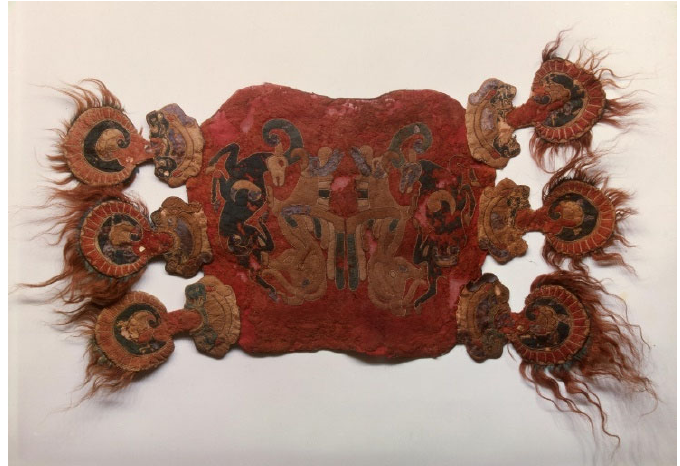
Figure 12. Saddle cover showing a griffin attacking a mountain sheep (SHM inv. no. 1295-150); felt and horsehair; Kurgan 1, Pazyryk, Altai mountains, Russia; late 4th to early 3rd century BC. [Image is used from www.hermitagemuseum.org (accessed 9 November 2022), courtesy of the State Hermitage Museum, St. Petersburg, Russia].